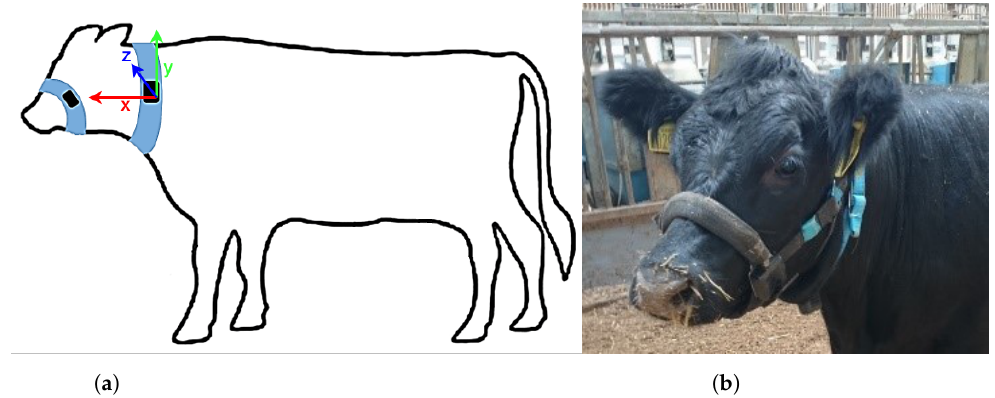
Figure 1. Placement of a RumiWatch muzzle-mounted halter and Afimilk Silent Herdsman neck- mounted collar. ( a ) Axis orientation diagram. ( b ) Photograph illustrating sensor